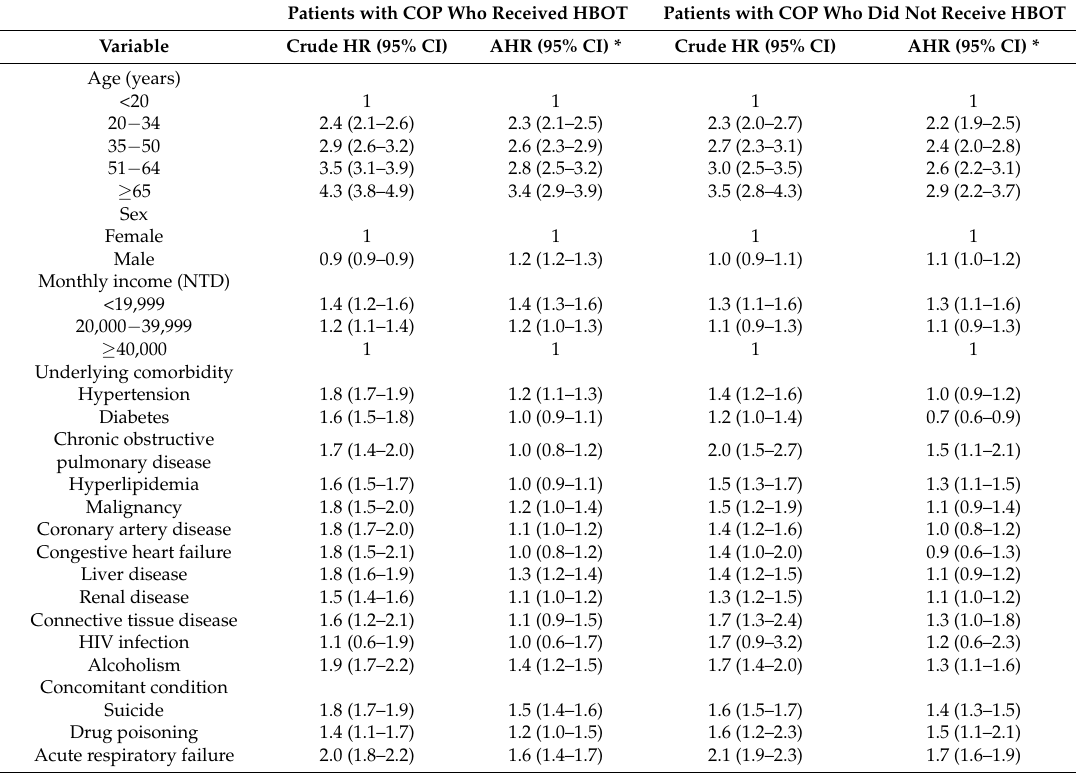
Table 3. Independent predictors for NS in patients with COP by Cox proportional hazard regression